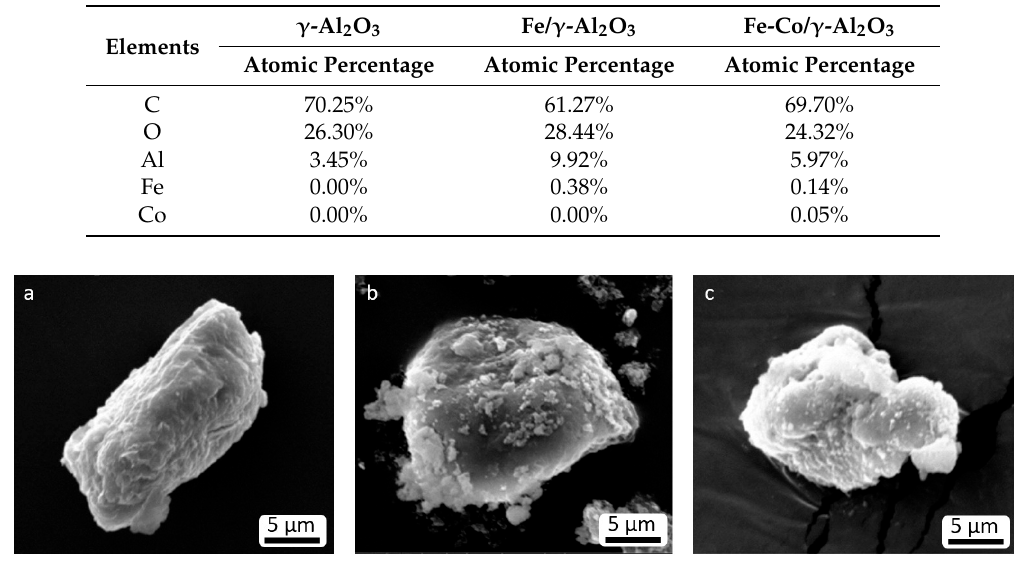
Figure 1. Scanning electron microscopy (SEM) images of ( a ) γ -Al 2 O 3 ; ( b ) Fe/ γ -Al 2 O 3 ; ( c ) Fe-Co/ γ -Al 2 O 3 .